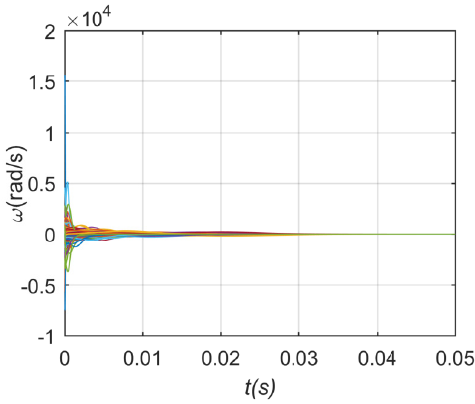
Figure 14. Frequency stabilization process of undirected network in case